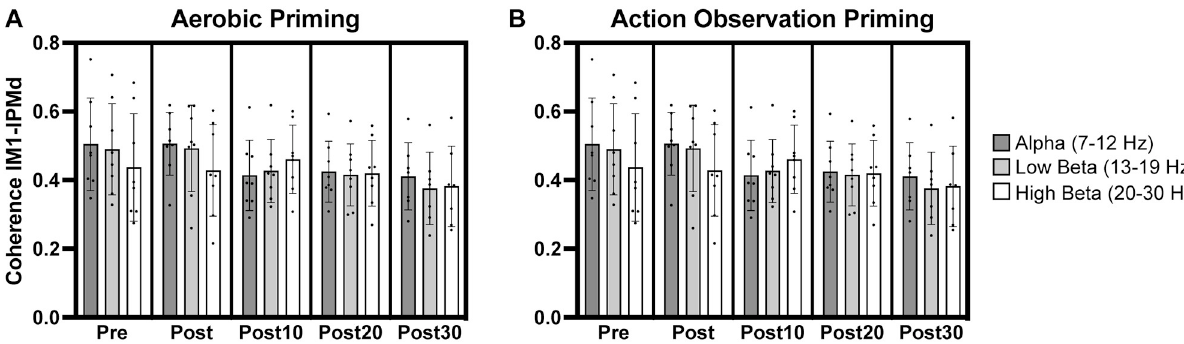
Fig 6. Coherence in leads overlying left primary motor (lM1) and left dorsal premotor (lPMd) cortices. Aerobic (A) and action observation (B) priming did not result in any significant change in alpha, low beta, or high beta lM1-lPMd coherence.